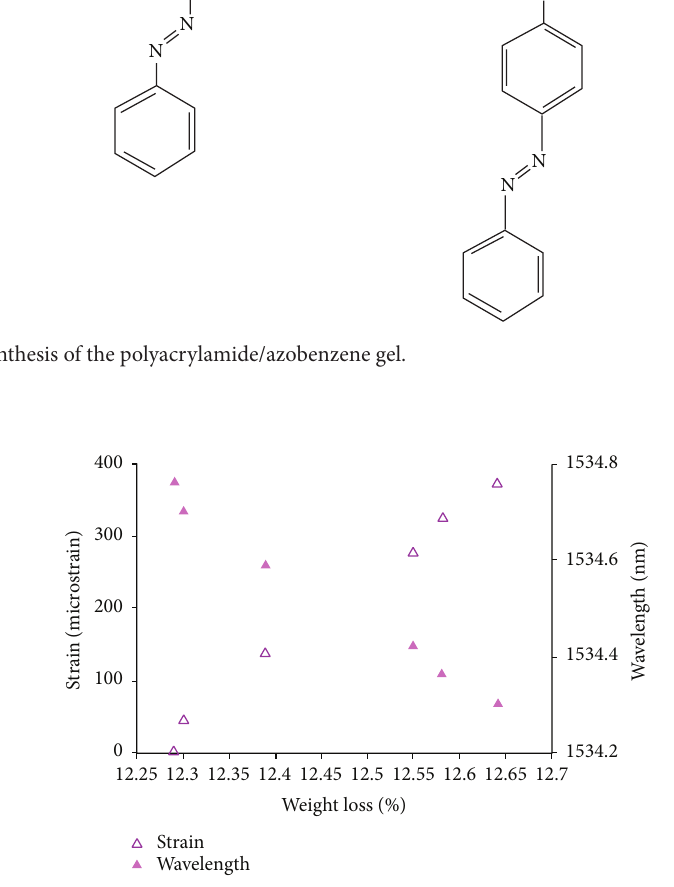
Figure 5: A plot of strain and wavelength against weight loss of